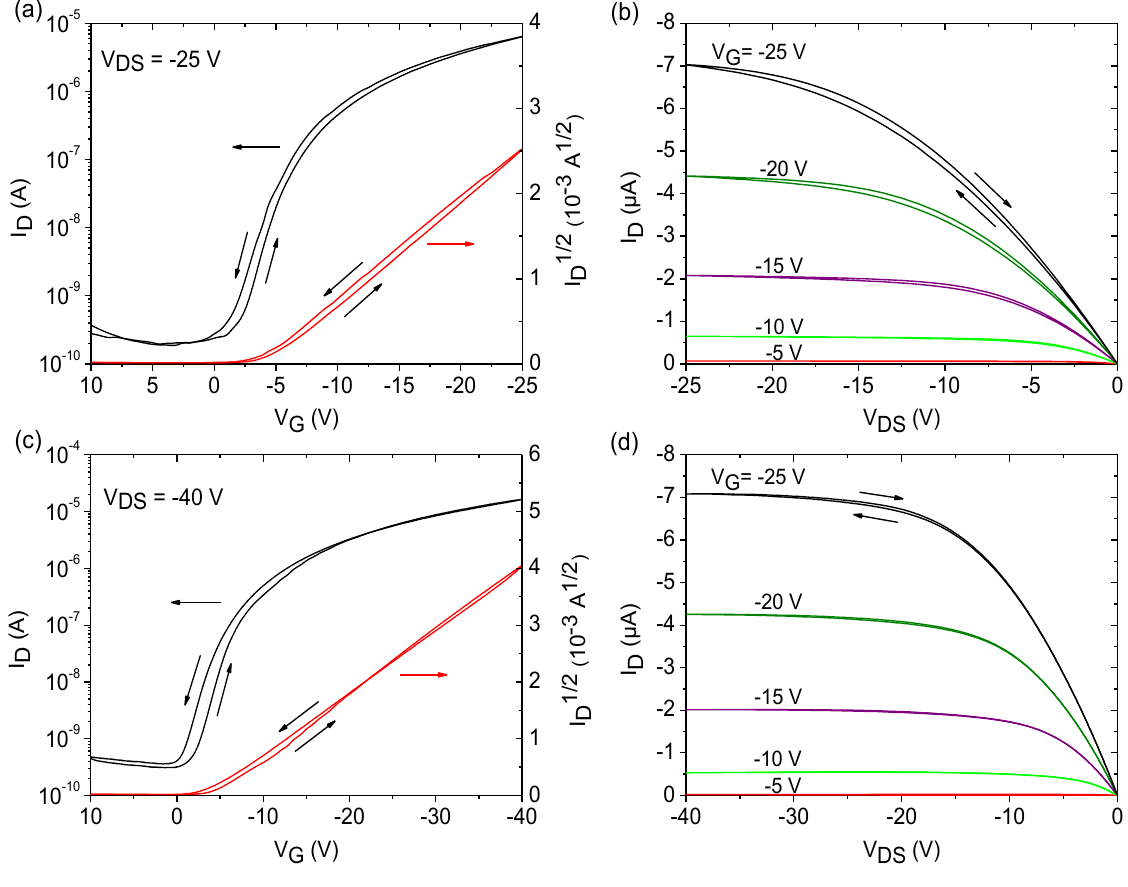
Figure 5. Representative transfer and output curves for OFET devices with the semiconductor, FS111, using SU-8 dielectrics on FOC at a supply voltage of − 25 V ( a , b ) and PVP dielectrics on glass at a supply voltage of − 40 V ( c , d ) with a channel width and length of 3.5 mm and 100 µ m, respectively.